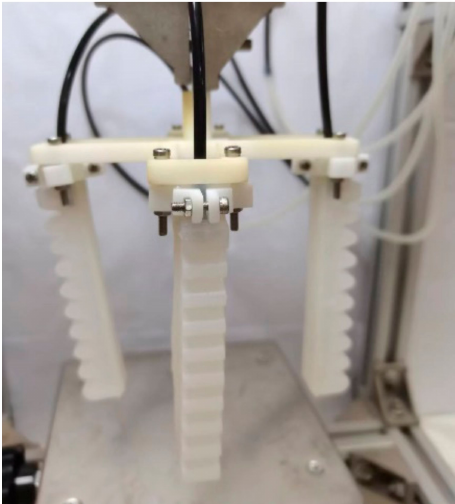
Figure 2. The pneumatic soft